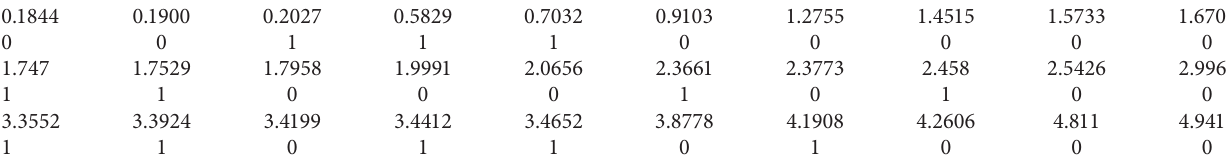
Table 3: The generated data under used conditions.